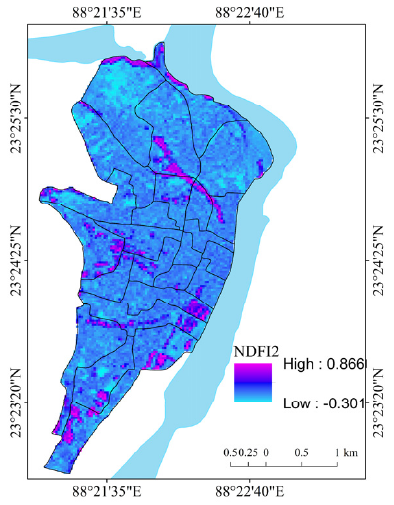
Figure 43. NDFI2 (2015).